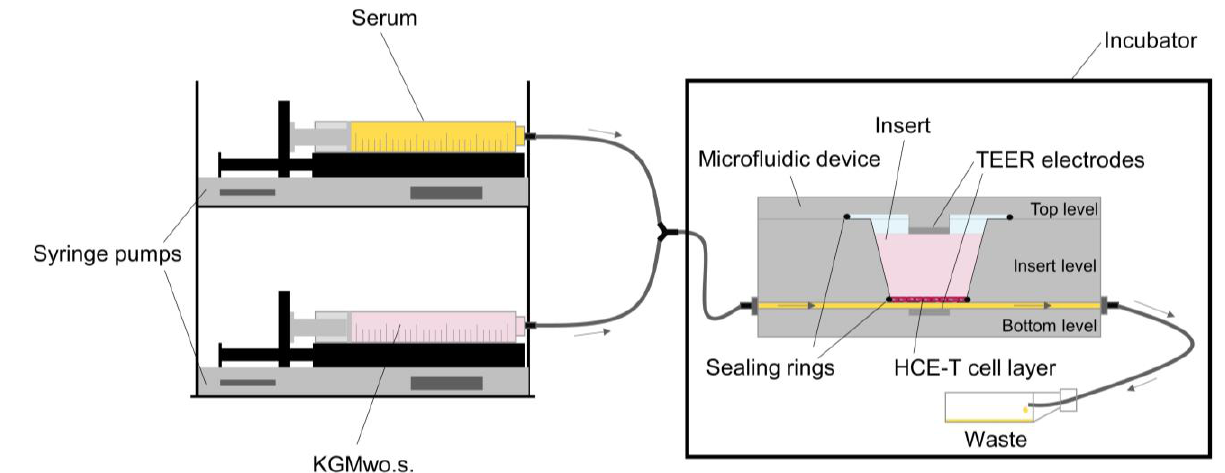
Figure 13. Microfluidic device (Ocular DynaMiTES) for the dynamic inflammatory DED model.